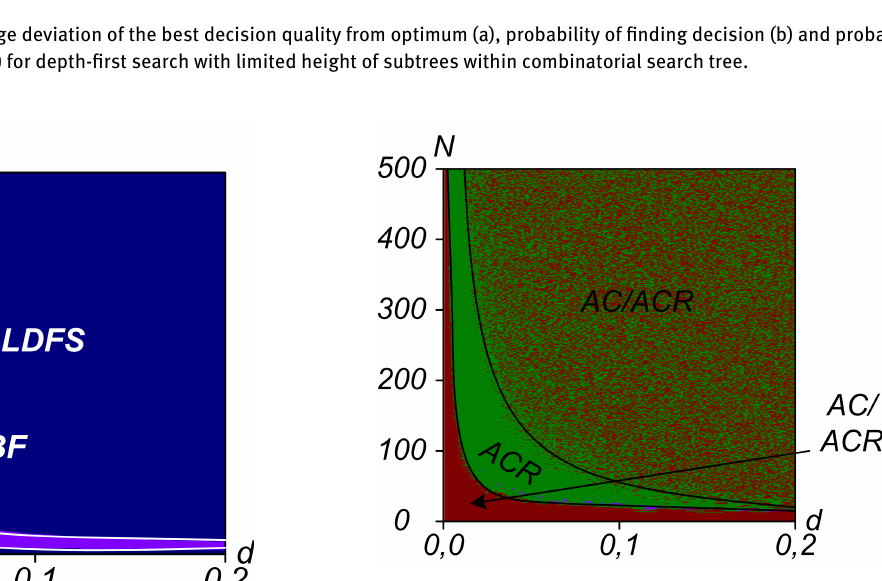
Figure 6: Comparison of decisions quality for described above LBF and LDFS methods with AC and ACR methods from [28] by criterion of maximum probability of finding the optimal